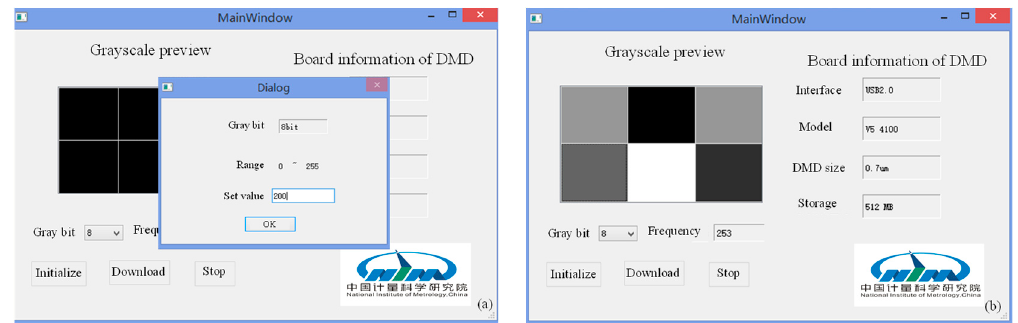
Figure 6. PC control interface. ( a )Main interface of the program; ( b ) Grayscale preview interface.